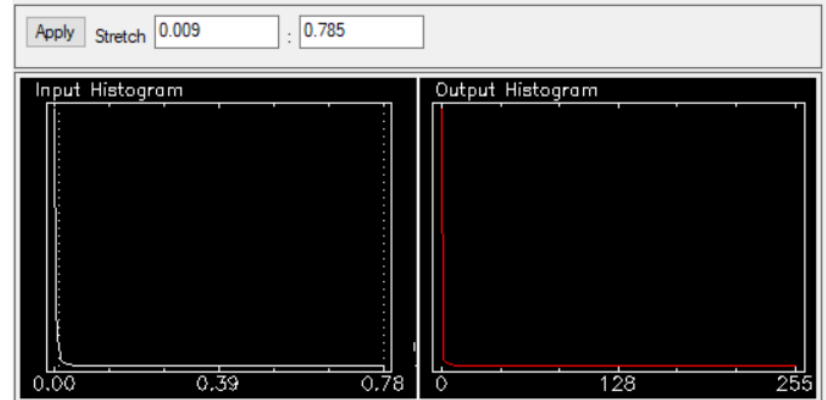
Figure 5. ACE histogram stretched for AIC isolation.